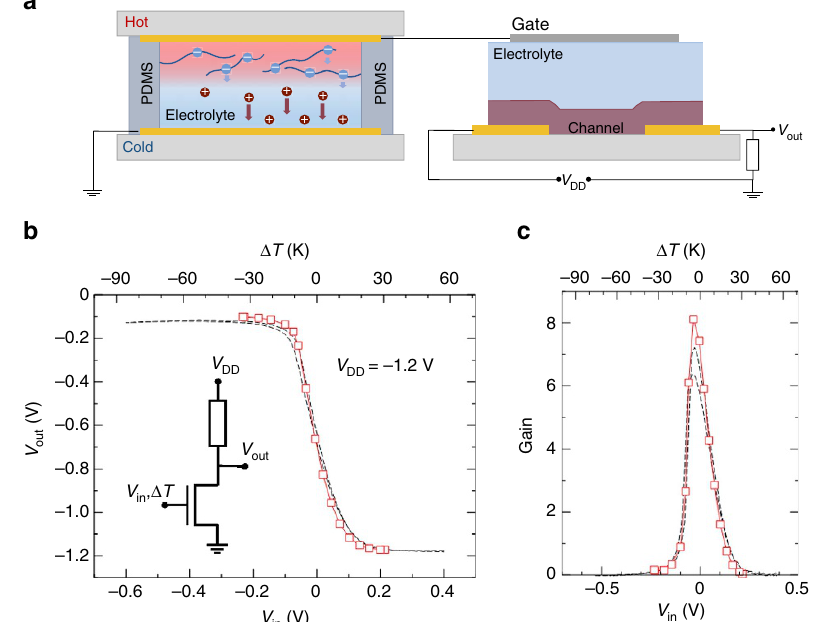
Figure 5 | Electrical characteristics of heat-gated inverters. Schematic diagram of the ionic thermoelectric-gated inverters ( a ). Output voltage response ( V out - D T and V out - V in ) of a resistor-loaded inverter based on a heat-gated transistor for V DD ¼ (cid:2) 1.2V and temperature gradient (cid:2) 32K o D T o 30K or supply input voltage (cid:2) 0.6V o V in o 0.4V. The inset shows the related circuit diagram ( b ). Corresponding signal gain of the inverter for different temperature gradient D T and supply input voltage V in ( c